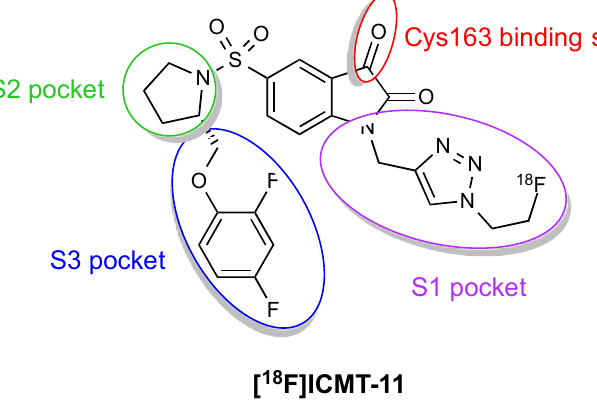
Figure 4. Pharmacophore model for [ 18 F]ICMT-11 binding to caspase-3/7.